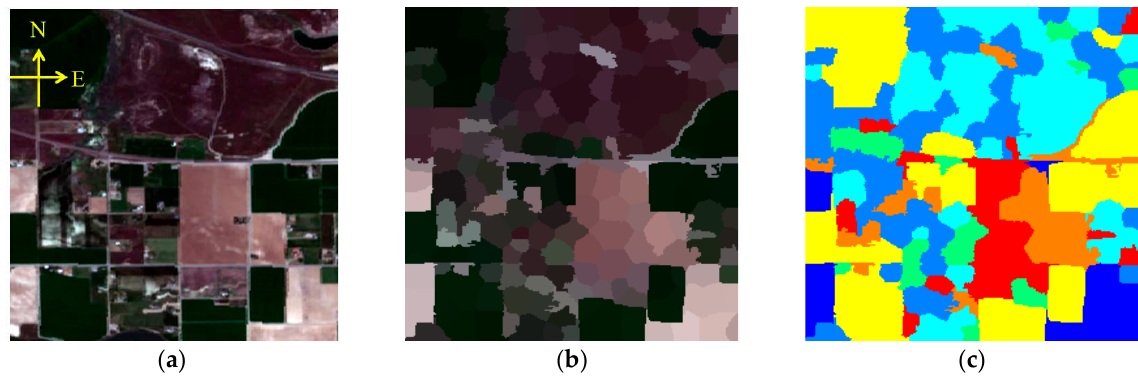
Figure 1. Superpixel-based Fast Fuzzy C-Means (SFFCM) clustering segmentation example. ( a ) Original image; ( b ) Superpixel image; ( c ) Output image.